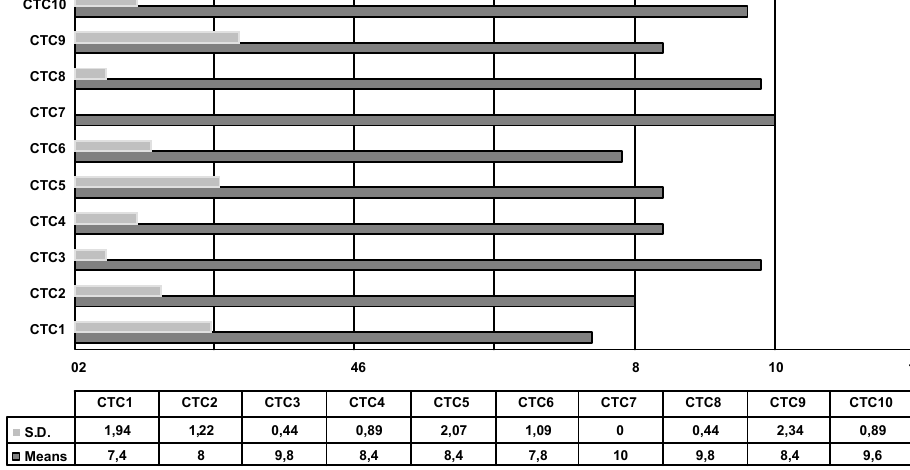
Figure 3. Self-assessment test